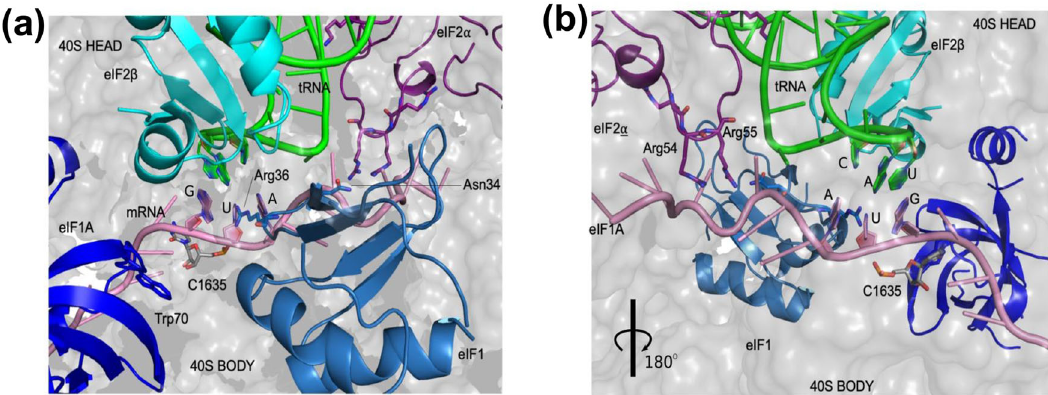
Fig. 4 Recognition of the start codon AUG by 48S PIC in open conformation. a , b The key players involved in the codon-anticodon interactions are shown in cartoon representation in two different views rotated by 180°. The corresponding residues which may augment codon: anticodon interactions are shown in stick representations. Arg36 of eIF1 (pale blue), interacts with the fi rst two codon bases, while Trp70 of eIF1A (blue) points towards the mRNA providing stacking interactions. eIF2 α shown in purple color contains Arg54 and Arg55 residues ( b ), which interact with mRNA. eIF2 β (cyan) interacts with both tRNA i and eIF1 at the P site. The tRNA i and mRNA are shown in green and